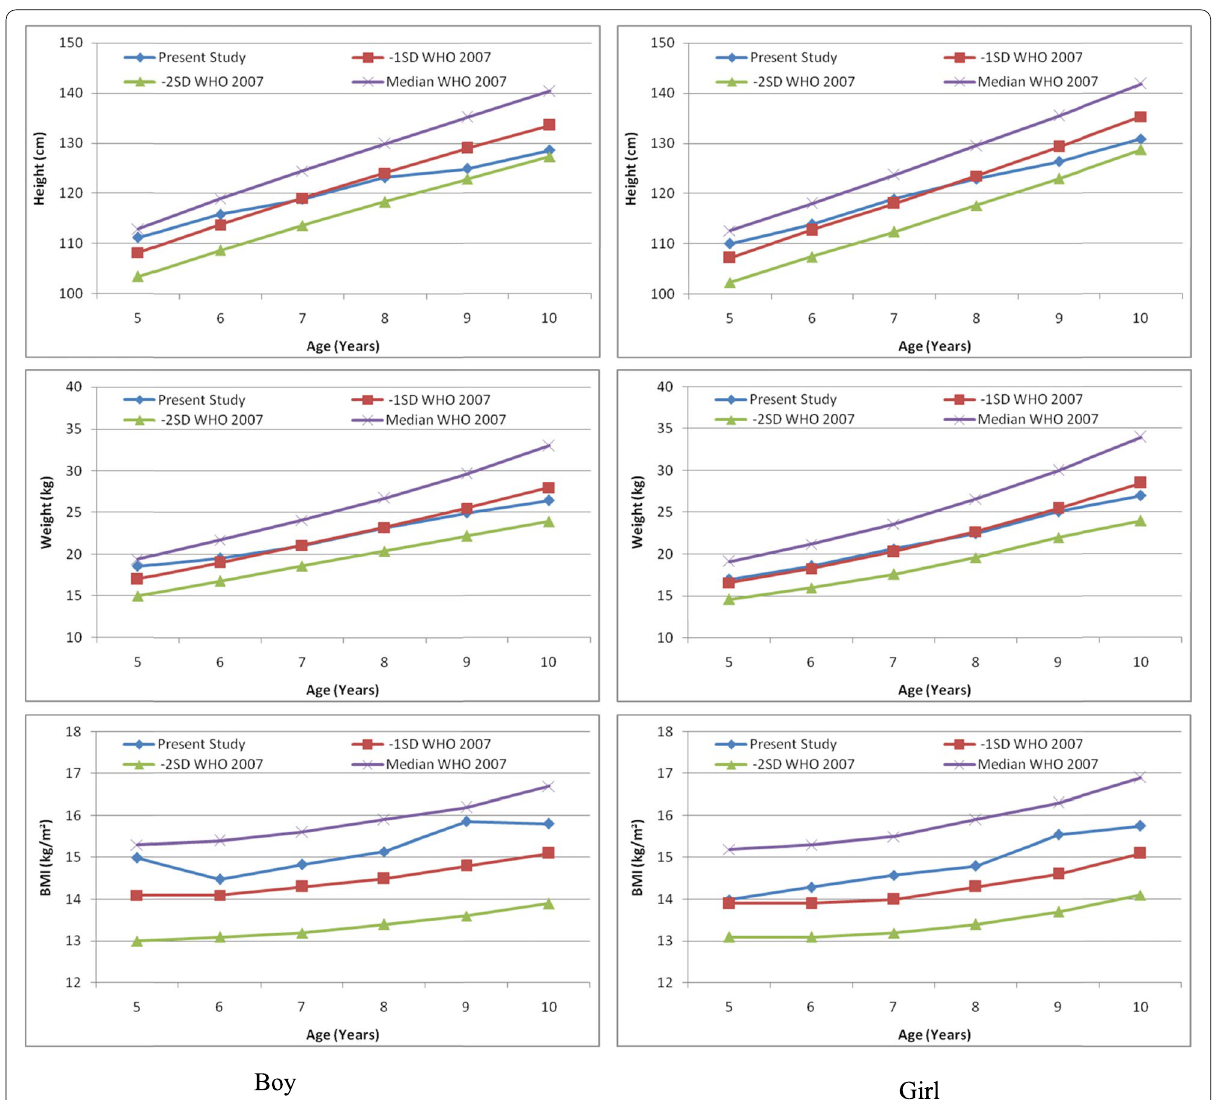
Fig. 1 Comparison of mean height, weight and BMI of the present study with WHO reference